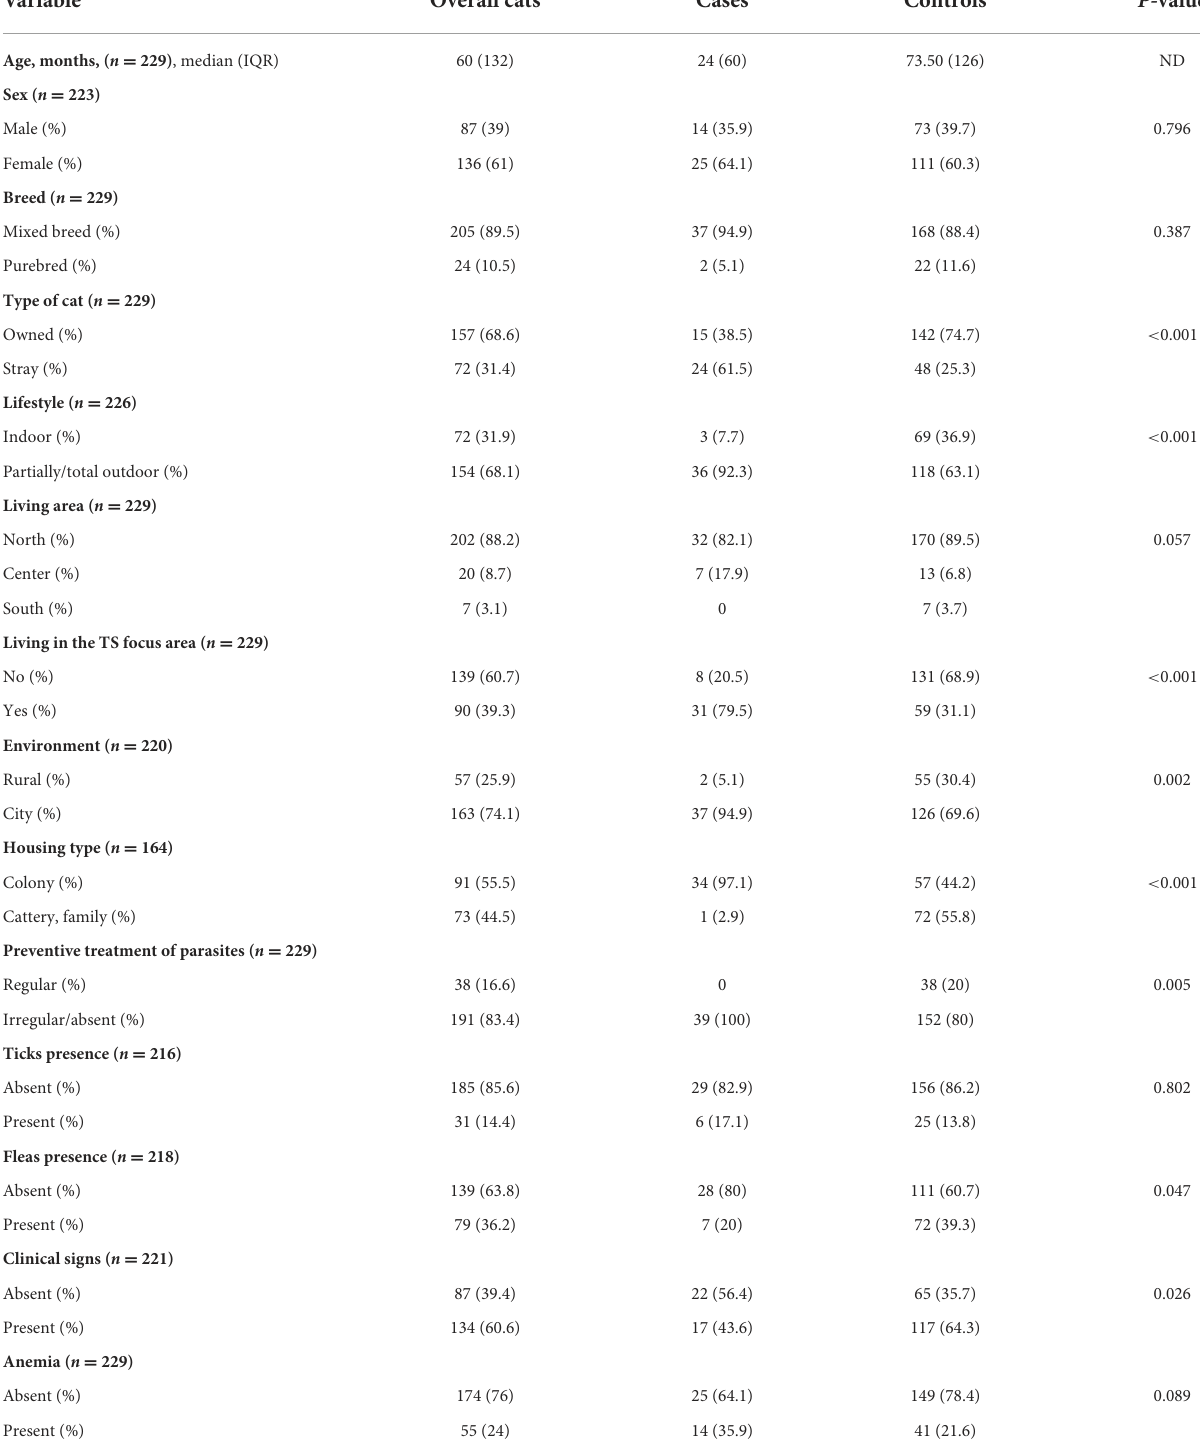
TABLE 1 Characteristics of patients at baseline in the total study population and in the case and control groups. Variable Overall cats Cases Controls P-